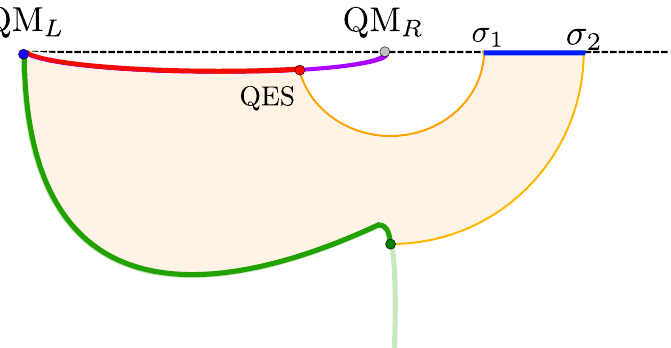
Figure 19. The shaded region is the volume which computes complexity of the bath subregion [ σ 1 , σ 2 ] ∪ QM L in a reconstructing